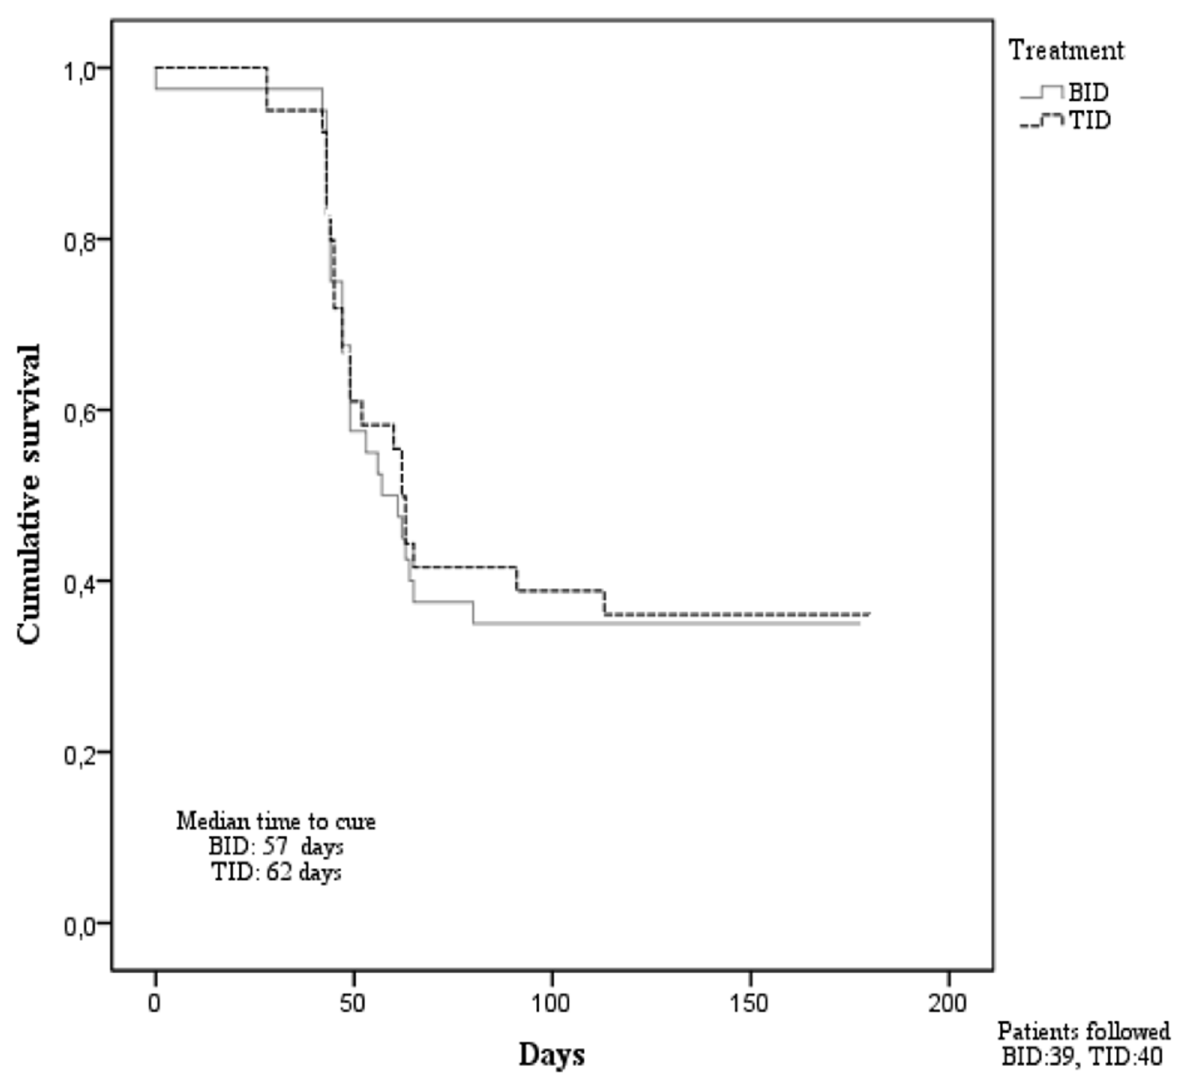
Fig 2. Survival analysis of time to healing of cutaneous leishmaniasis